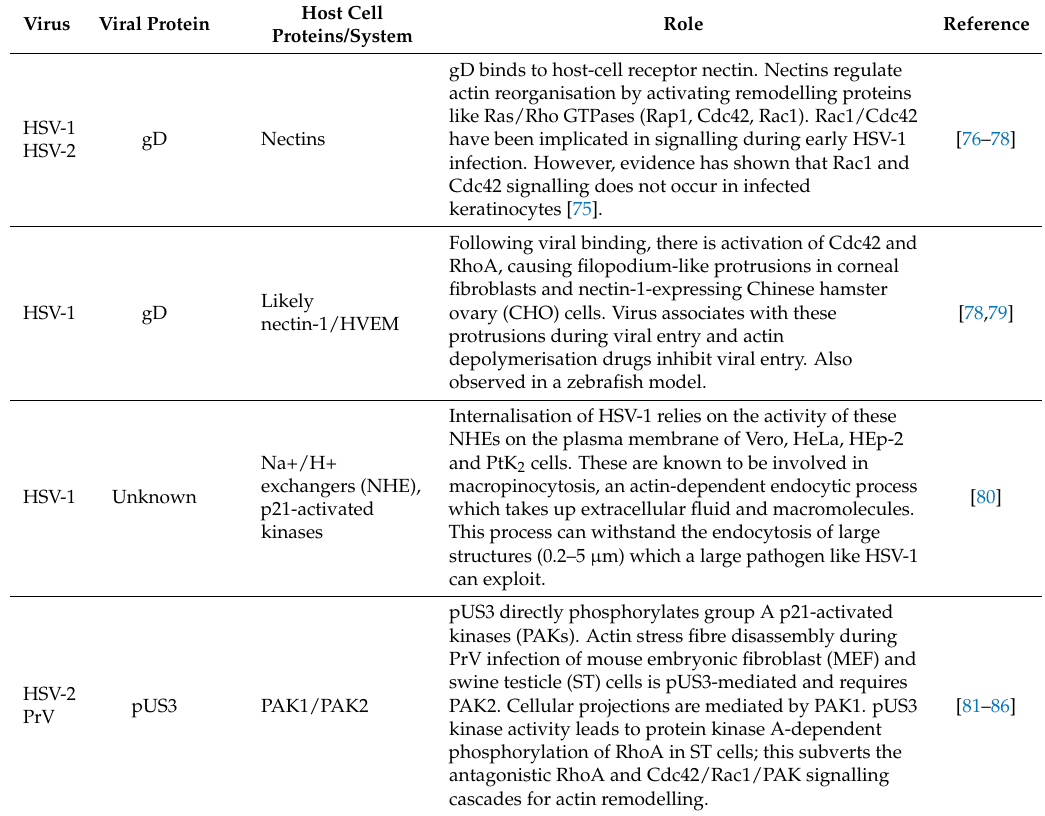
Table 1. Alphaherpesvirus-host interactions that regulate actin